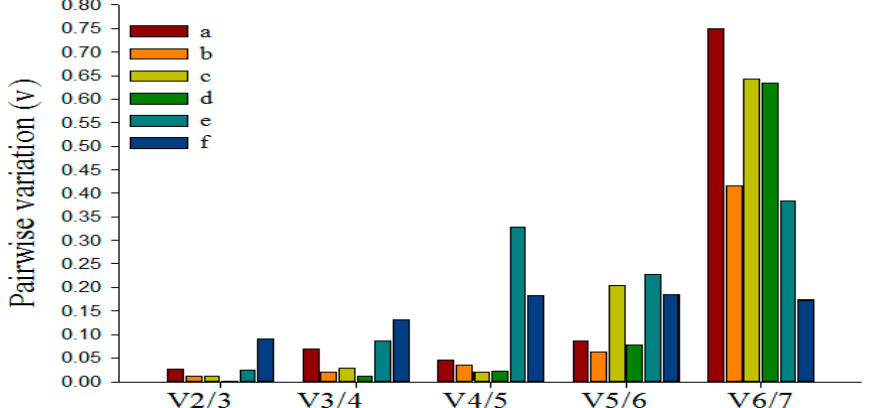
Figure 4. Determination of the optimal number of reference genes. Pairwise variation calculated by geNorm to determine the minimum number of reference genes for accurate normalization in: ( a ) E. oblique attack; ( b ) mechanical wounding; ( c ) SA; ( d ) MeJA; ( e ) ABA; ( f ) the bud to the second leaf. Each column shows a change in normalization accuracy when another endogenous control is added according to the ranking in Figure 3.